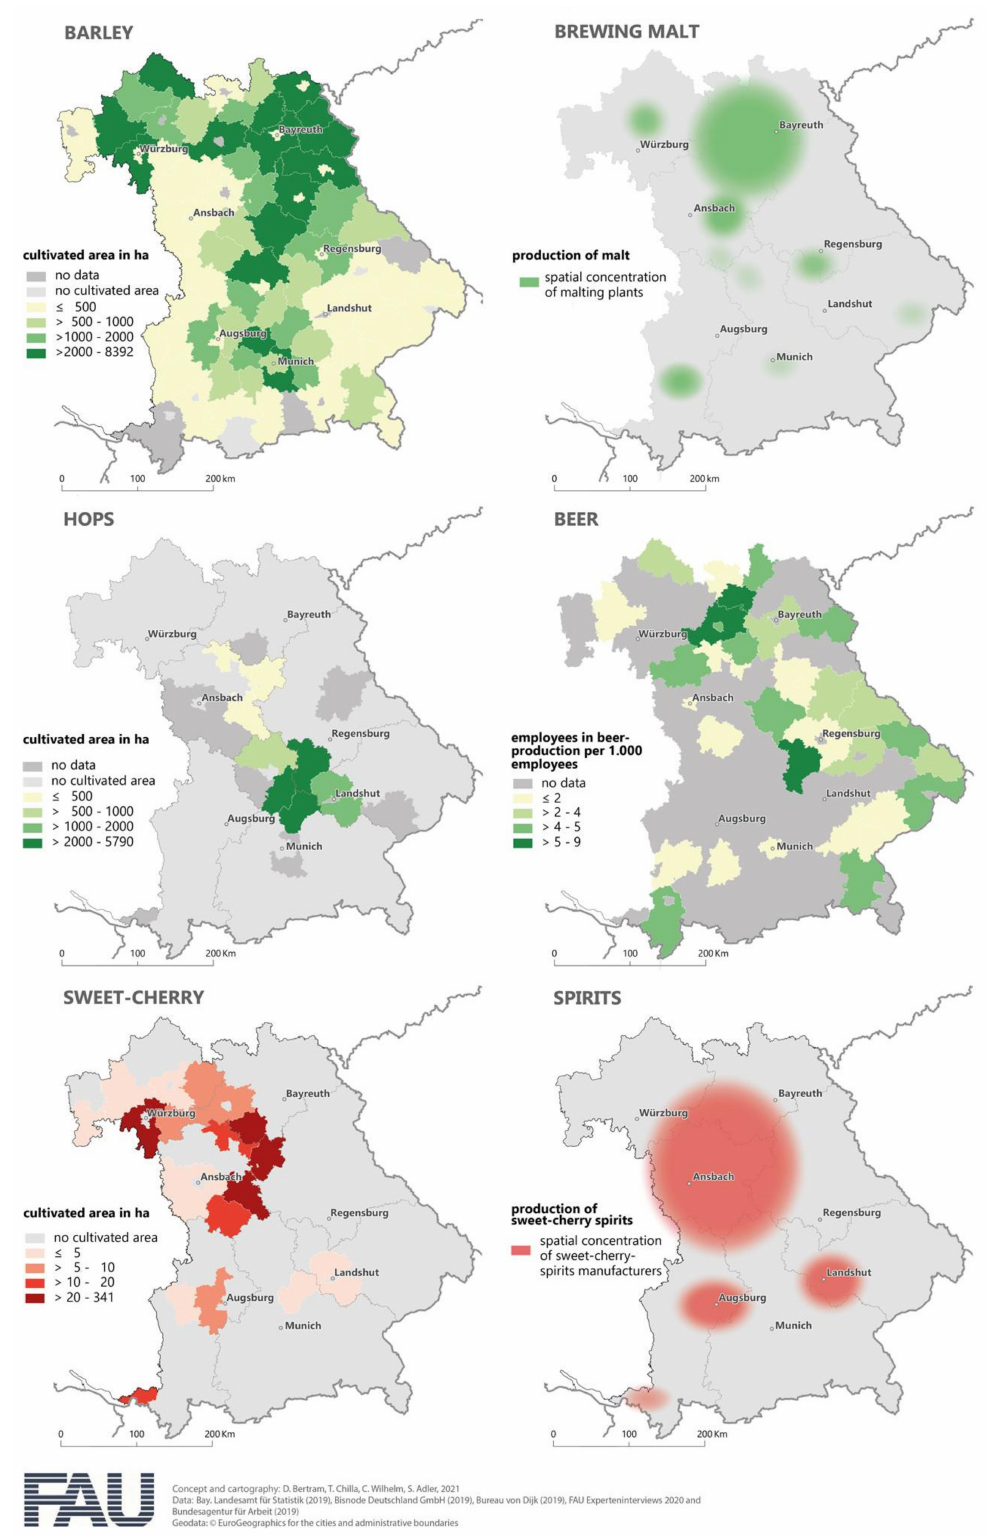
Figure 3. Localized activities and land use